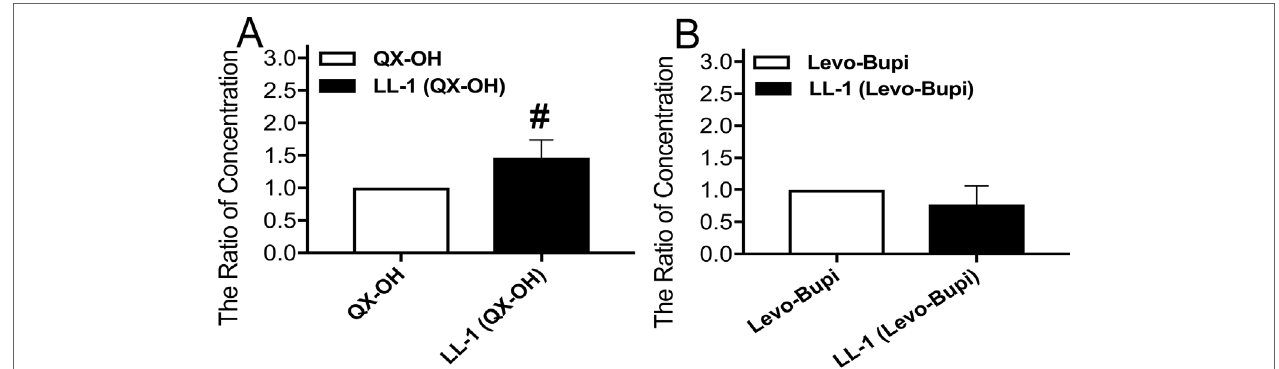
FIGURE 4 | The ratio of concentration by cellular drug uptake in HT22 cells (n = 10 in each group). (A) QX-OH; (B) Levo-Bupi. Data are expressed as mean ± SEM. # p < 0.001. Levo-Bupi, levobupivacaine; LL-1, 35 mM QX-OH/10 mM